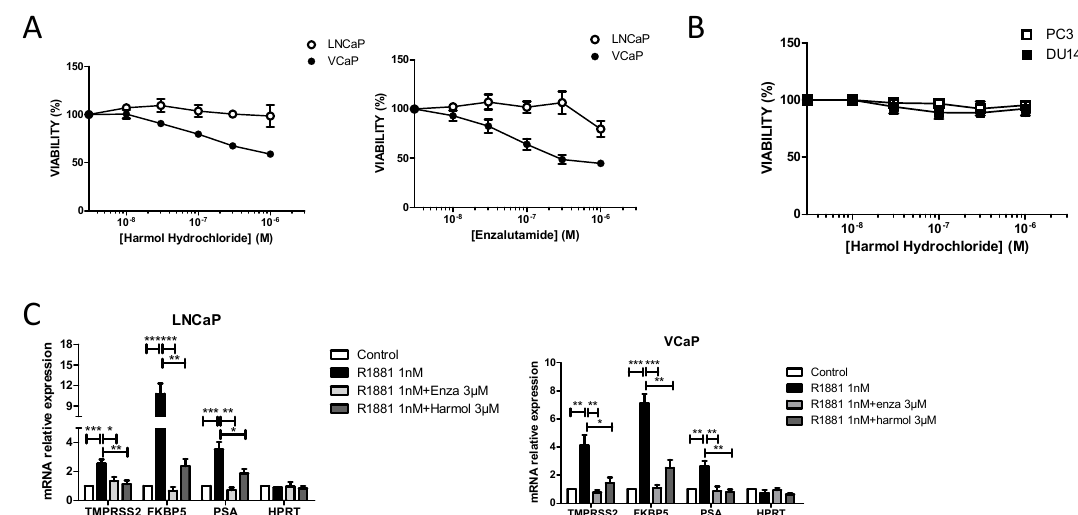
Figure 5. Harmol-mediated growth inhibition of LNCaP and VCaP cells is associated with the repression of AR target genes. ( A ) Effects of harmol hydrochloride and enzalutamide on the growth of LNCaP and VCaP spheroids. ( B ) Effects of harmol hydrochloride on the growth of PC3 and DU145 spheroids. Spheroids were treated for 7 days, and cell death was evaluated by propidium iodide staining and fluorescence quantification, using the Celigo imaging system. Growth inhibition was then assessed by cell lysis with CellTiter-Glo, and quantification of the luminescence using a MicroBeta Wallac luminometer. Percent growth was calculated relative to dimethyl sulfoxide (DMSO) treated cells ( n = 3 ± SEM). ( C ) Effects of harmol hydrochloride and enzalutamide on the expression of AR target genes TMPRSS2, FKBP5, and PSA in LNCaP and VCaP cells. Cells were treated for 24 h with 3 µM harmol hydrochloride or enzalutamide in the presence of 1 nM R1881, and gene expression was evaluated by RT-qPCR. The HPRT gene was used as an AR non-target gene. Results are expressed as mRNA relative expression, as compared to untreated spheroids ( n = 4 ± SEM). * p ≤ 0.05; ** p ≤ 0.01; *** p ≤ 0.001.